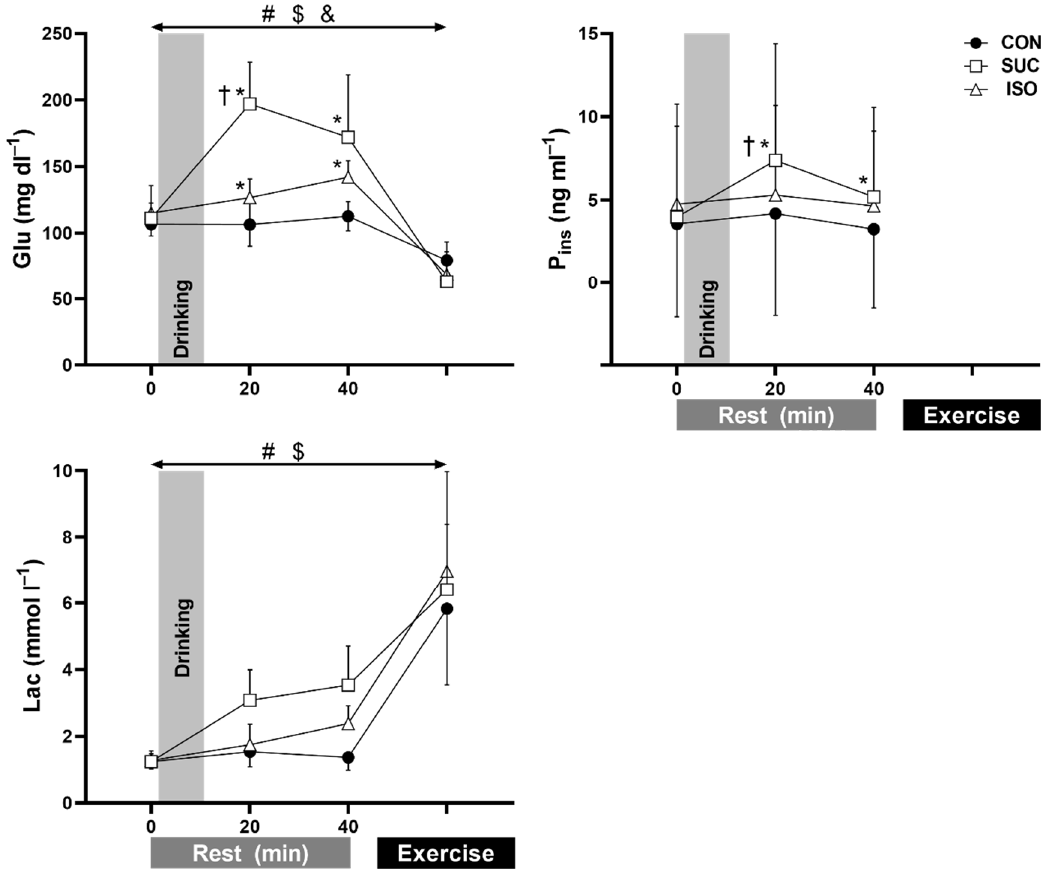
Figure 3. Blood glucose (Glu, n = 10), plasma insulin (P ins , n = 7), blood lactate (Lac, n = 10) concentrations at rest and during exercise at the seventh minute of peak oxygen uptake. Insulin data are missing because of limited blood sample volume. CON, control (water); SUC, sucrose; ISO, isomaltulose. Values are presented as mean ± SD. * p ≤ 0.031 vs. CON at each time point; †, p ≤ 0.047 vs. ISO at each time point. #, p ≤ 0.001 group difference in beverage between SUC vs. CON; $, p ≤ 0.035 group difference in beverage between ISO vs. CON. &, p = 0.006 group difference in beverage between SUC vs.